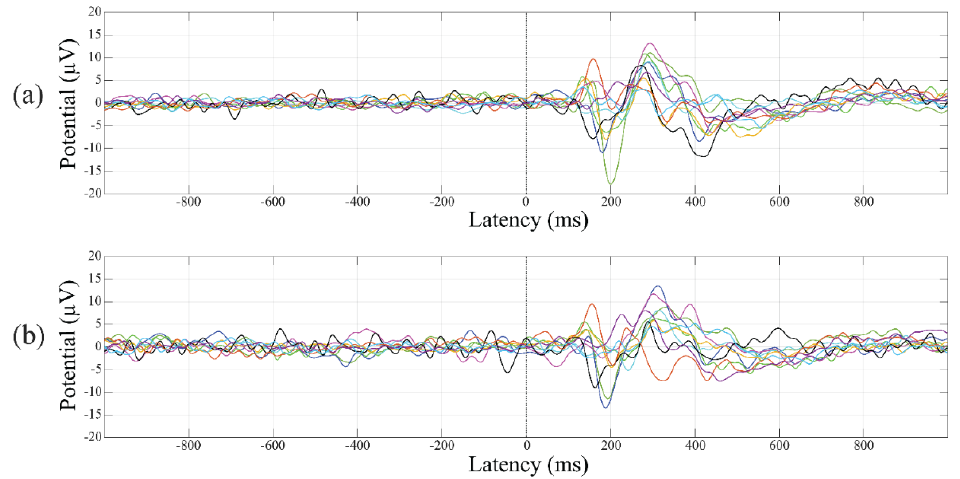
Figure 1. O2, baseline activity in for pre- and post-SD sessions. The average O2 time course of EEG activity evaluated in pre- ( a ) and post- ( b ) SD sessions for each participant analyzed have been superimposed before and after the stimulus onset. Individual participants are represented by lines of different colors. The color code is the same in ( a , b ).